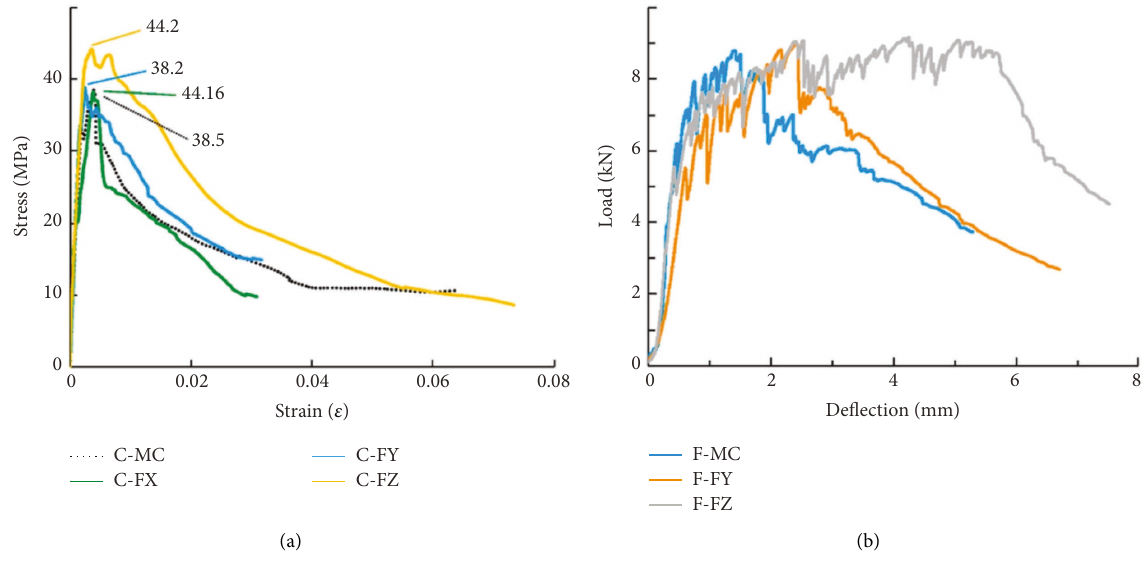
Figure 23: Compressive strength (a) and bending strength (b) of UHDC concrete